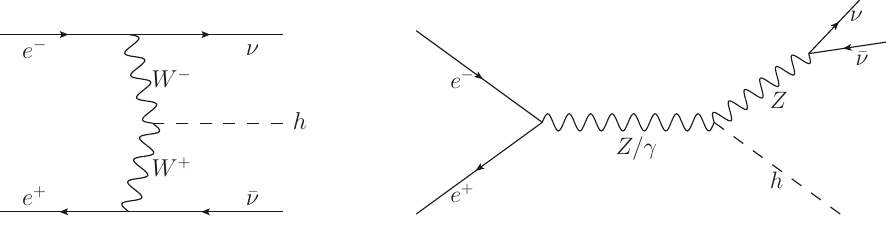
Figure 3 . Two contributions to the e + e hZ; Z (cid:23) (cid:22) (cid:23) !